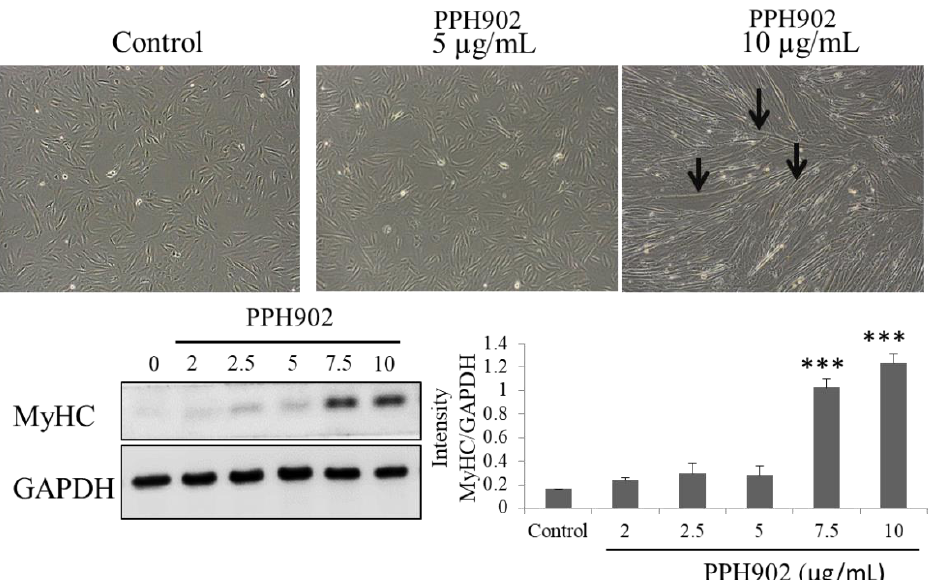
Figure 4. Effect of PPH902 on myogenic differentiation. Treatment with PPH902 showed a dose-dependent increase in the myogenic differentiation of C2C12 cells. Representative Western blots show an increase in the levels of MyHC in C2C12 cells upon treatment with different doses of PPH902. *** p < 0.001 indicates significant differences with respect to control group.